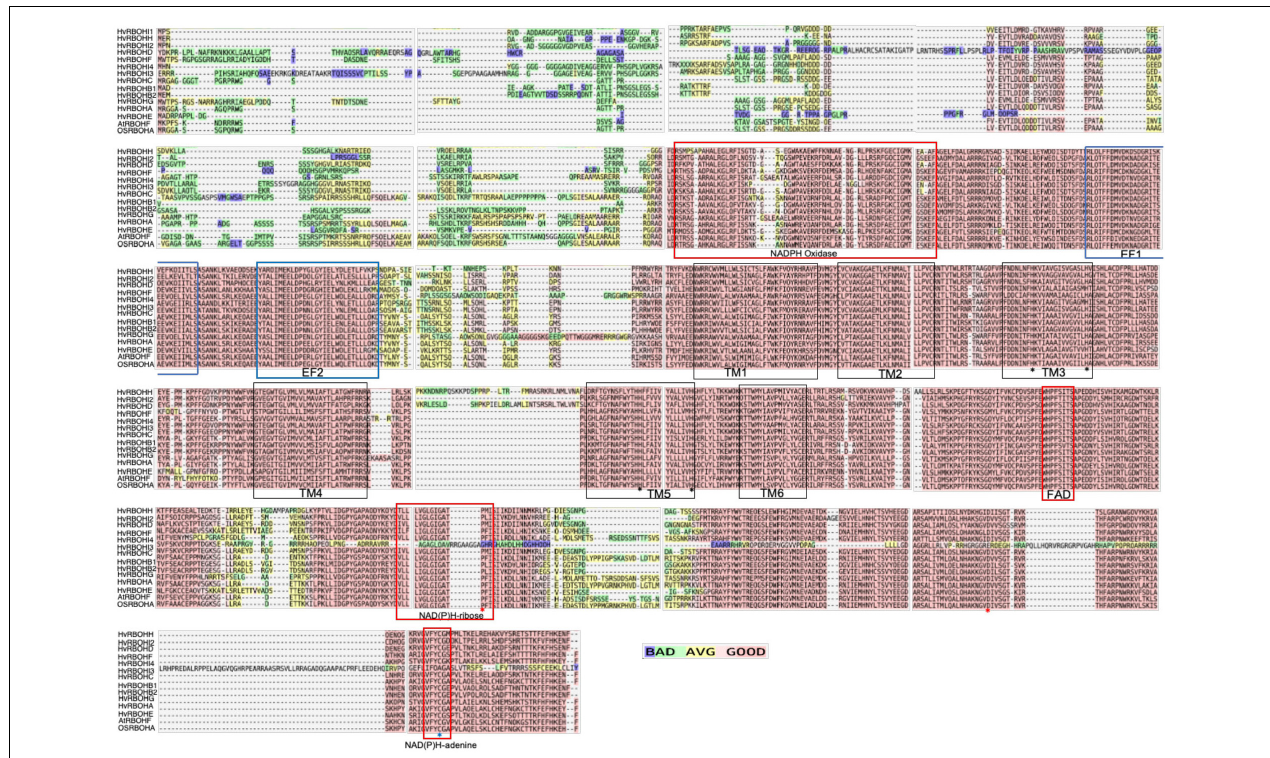
FIGURE 2 | T-Coffee based alignment of HvRBOH protein sequences. The Arabidopsis AtRBOHF and the rice OsRBOHA sequences are also included in this analysis. The color scale represents good, average and poor alignment among these sequences. EF hand domains are indicated by blue boxes. The NADPH oxidase and other co-factor binding domains are marked with red boxes. The five transmembrane domains are enclosed in black boxes. Histidine residues important for heme binding are shown with black asterisk, conserved proline and aspartate residues for enzyme activity are marked by red asterisks and the conserved cysteine residue for nitrosylation is indicated by a blue